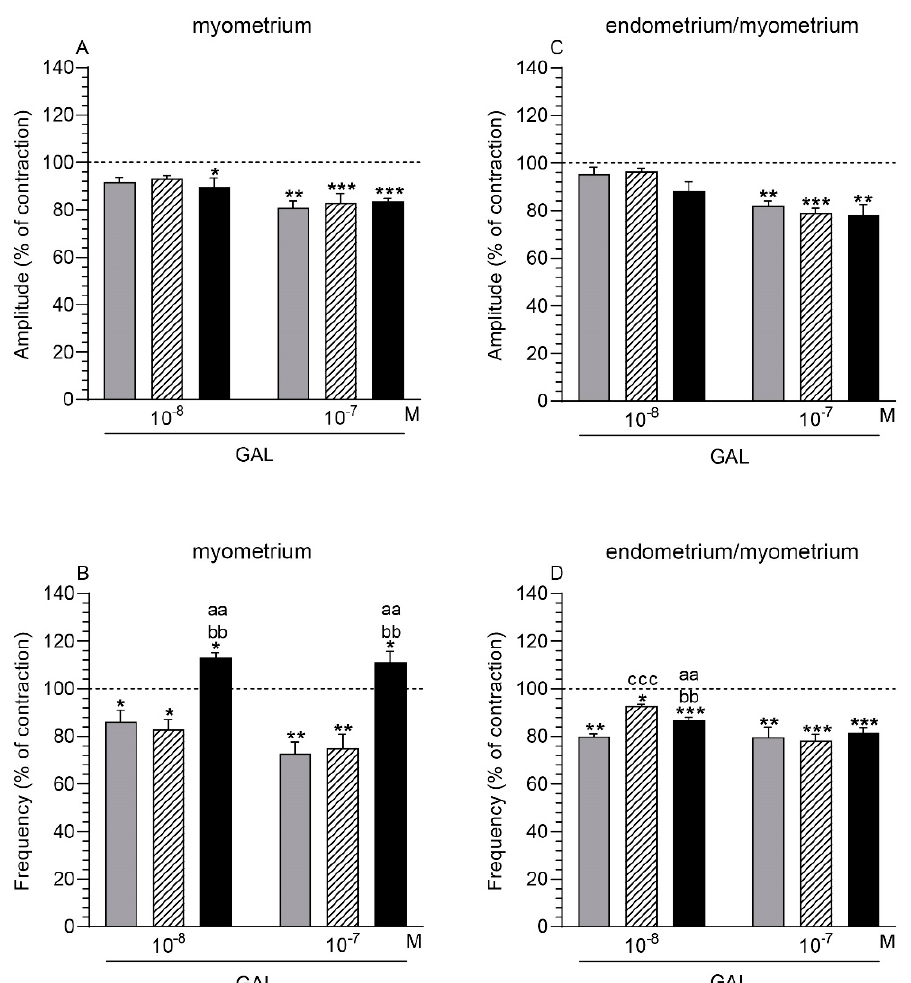
Figure 3. The influence of galanin (GAL) on the contractile amplitude ( A , C ) and frequency ( B , D ) in the myometrium ( A , B ) and endometrium/myometrium ( C , D ) stripes of gilts from the CON (grey bars), SAL (hatched bars), and E. coli (black bars) groups. Results were calculated for five gilts in each group. The effects of individual GAL doses are depicted as percentages (mean ± SEM) of the baseline (pretreatment period) contractile amplitude and frequency, taken as 100% (horizontal lines). * p < 0.05, ** p < 0.01, *** p < 0.001 compared to the basal value in each group; aa p < 0.01 compared between the CON and E. coli groups for the same treatment; bb p < 0.01 compared between the SAL and E. coli groups for the same treatment; ccc p < 0.001 compared between the CON and SAL groups for the same treatment.